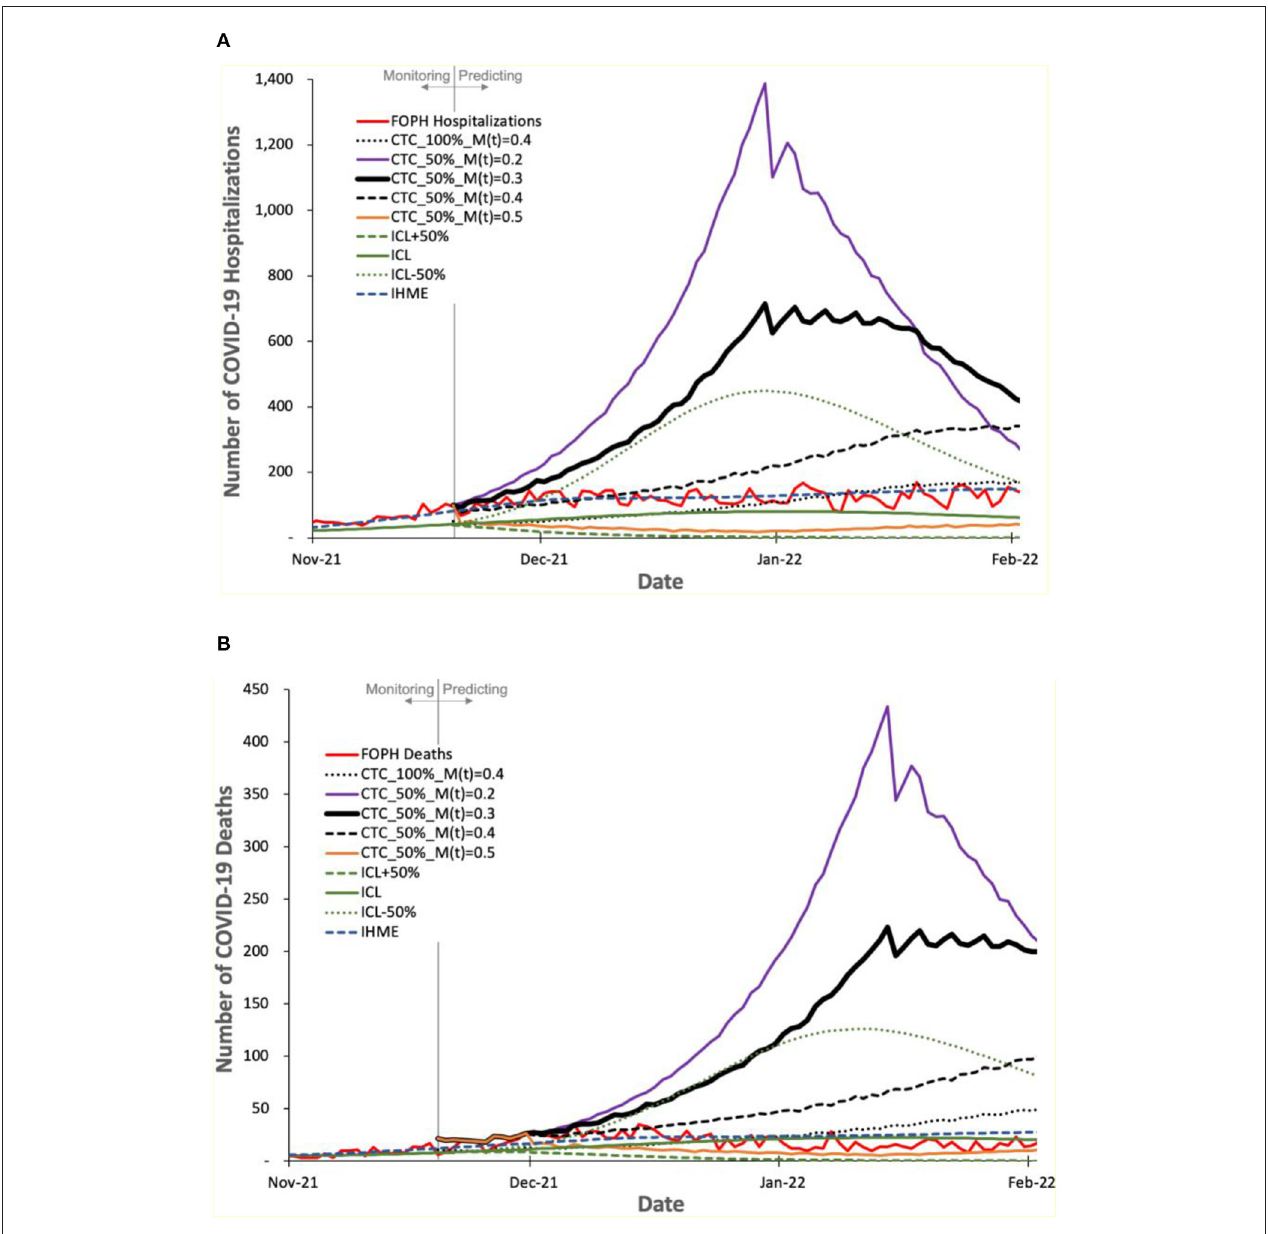
FIGURE 8 | Predicted number of COVID-19 (A) hospitalizations and (B) deaths by COVIDHunter, ICL, and IHME, compared to the real numbers (FOPH Hospitalizations and FOPH Deaths) released after performing the